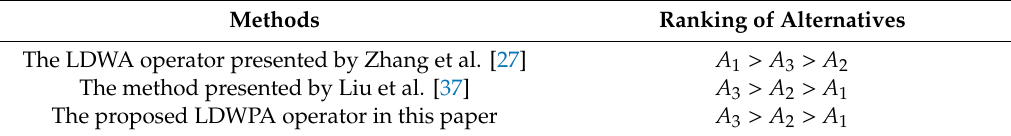
Table 8. Comparison of the results obtained using the three methods. Methods